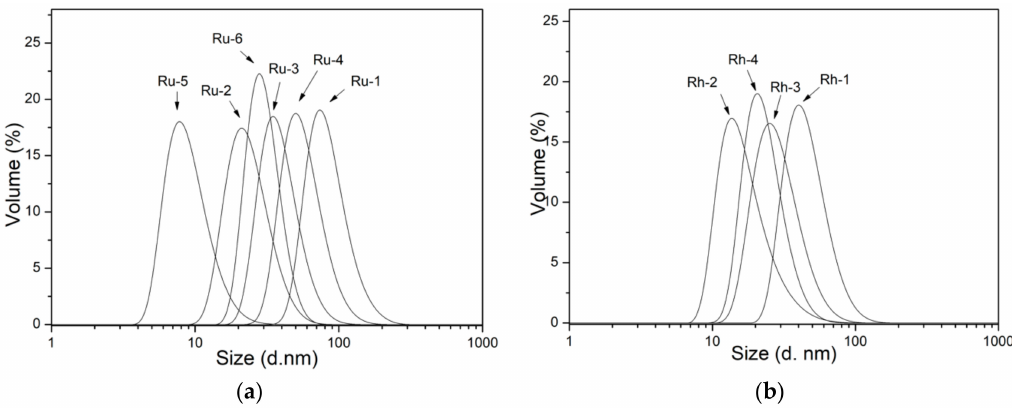
Figure 5. Dynamic light scattering (DLS) size distribution plots of as-synthesized ( a ) Ru and ( b ) Rh NPs dispersed in DI water at pH 7. For the details of labeling see Table